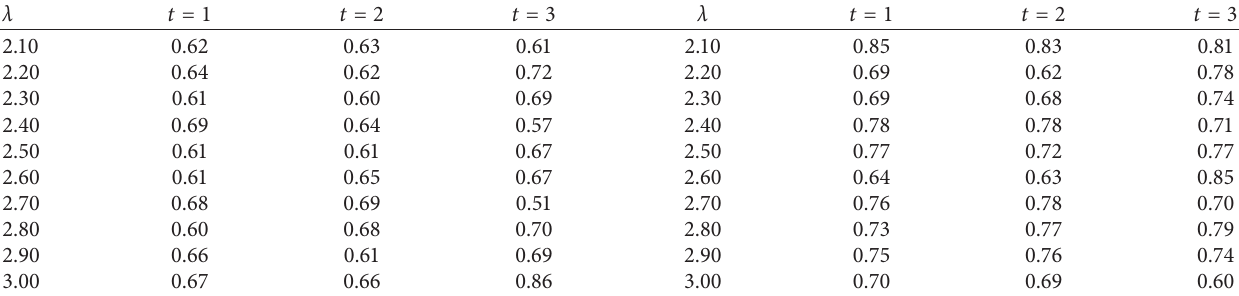
Table 8: Comparison of optimal Z